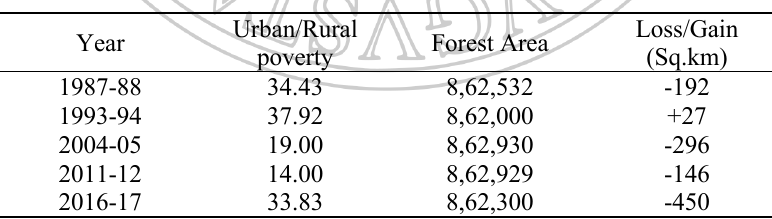
Figure 6 : Village having higher level of poverty in